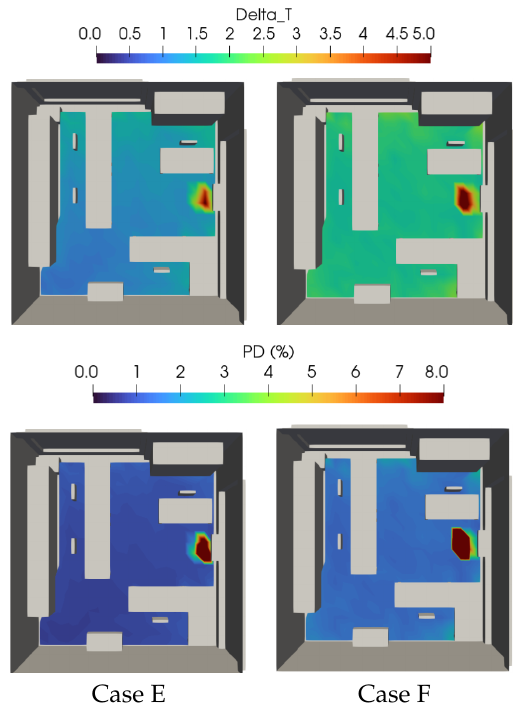
Figure 10. Winter heating condition. Vertical air temperature gradients (top subfigures) and relative percentage of dissatisfied (bottom subfigures) obtained with low input air velocity (Case E) and high input air velocity (Case